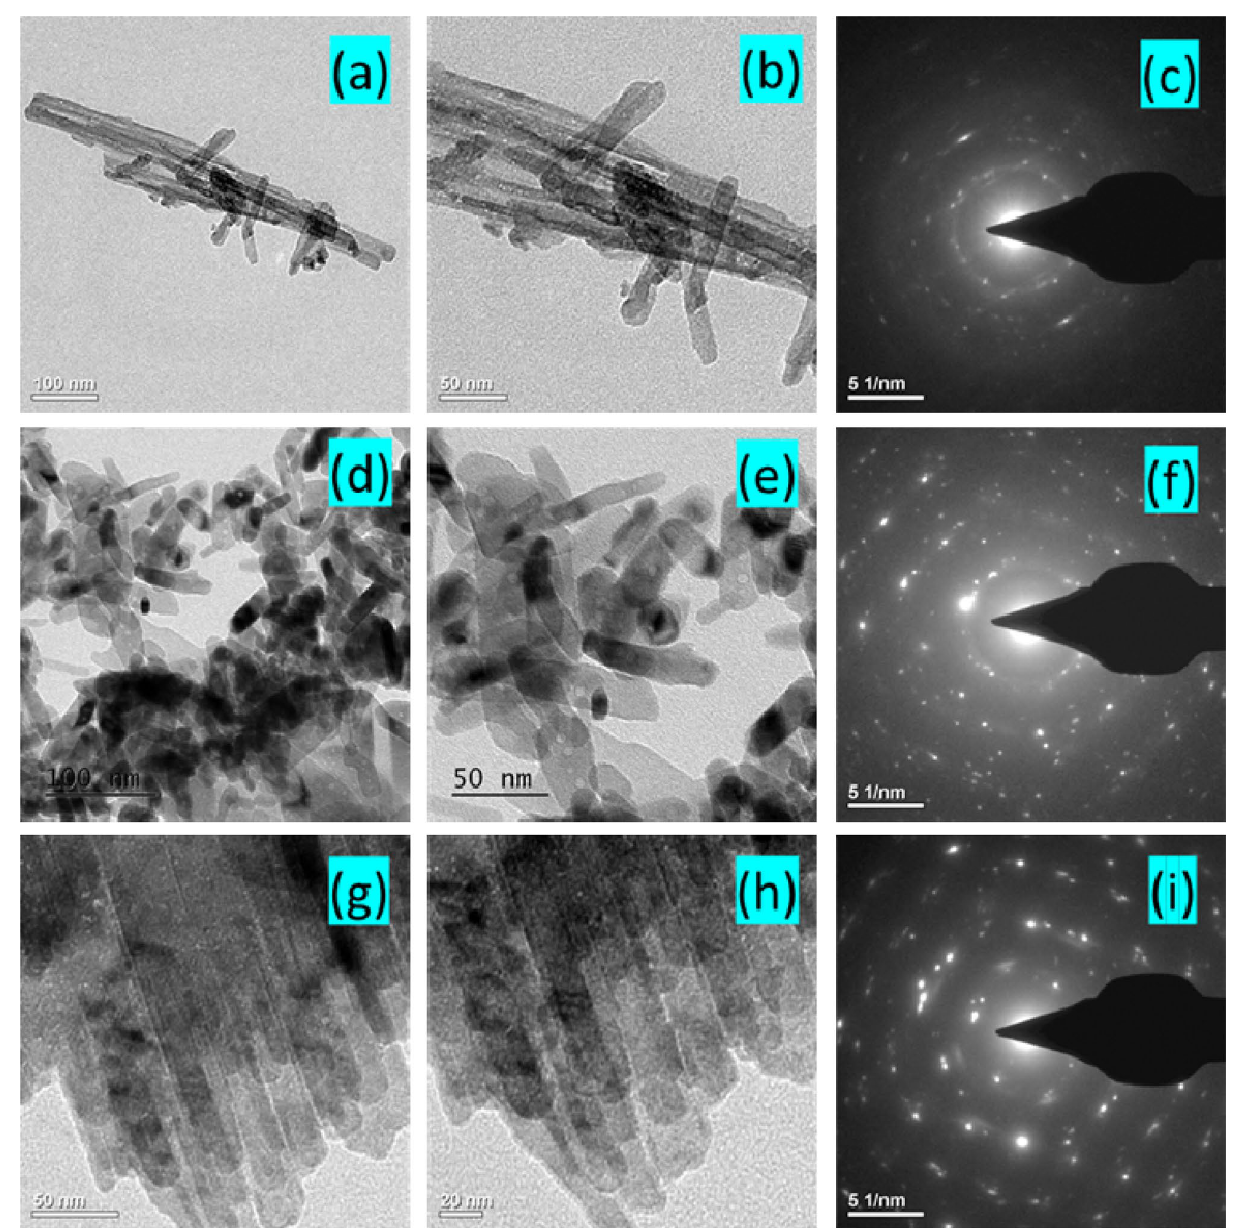
Figure 3. TEM images and SAED patterns of nanoparticles: ( a – c ) Cu 2 O nanorods; ( d – f ) CuO nano rice and ( g – i ) well-aligned CuNa 2 (OH) 4